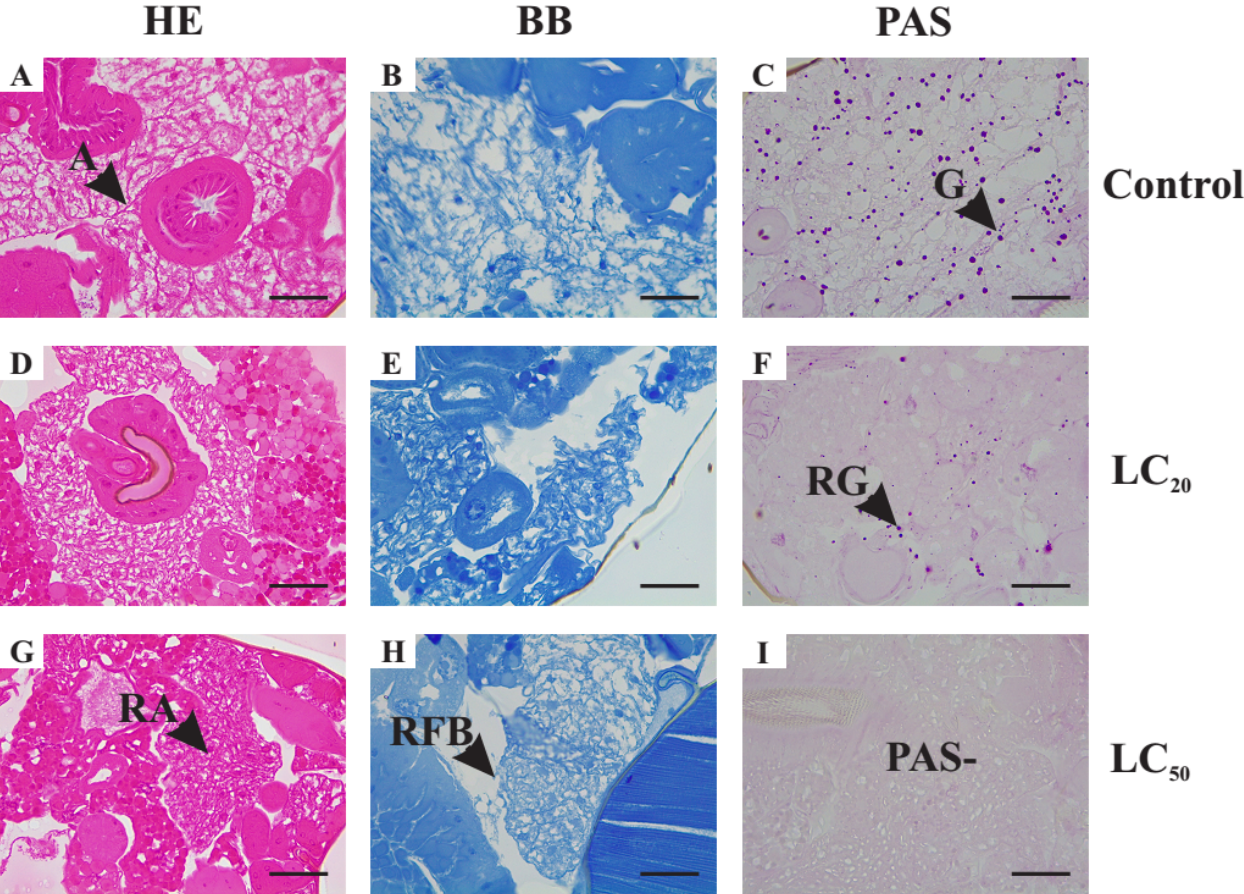
Figure 3. Histological sections of fat body of adult Drosophila suzukii females stained with Hematoxylin and Eosin (HE) ( A , D , G ), Bromophenol blue (BB) ( B , E , H ) and periodic acid–Schiff technique (PAS) ( C , F , I ). Control Group II (C II) ( A – C )—3% DMSO solution. Treatment group I ( D – F )—1 μ L mL − 1 (LC 20 ) of the essential oil of Illicium verum diluted in 3% DMSO. Treatment group II ( G – I )—2 μ L mL − 1 (LC 50 ) of the essential oil of I. verum diluted in 3% DMSO. Scale bars: 50 μ m. Legends: A—adipocytes; G—glycogen granules; PAS − —PAS negative region; RA—reduced adipocytes area; RFB—reduced fat ‐ body area; RG—reduced number of glycogen granules.